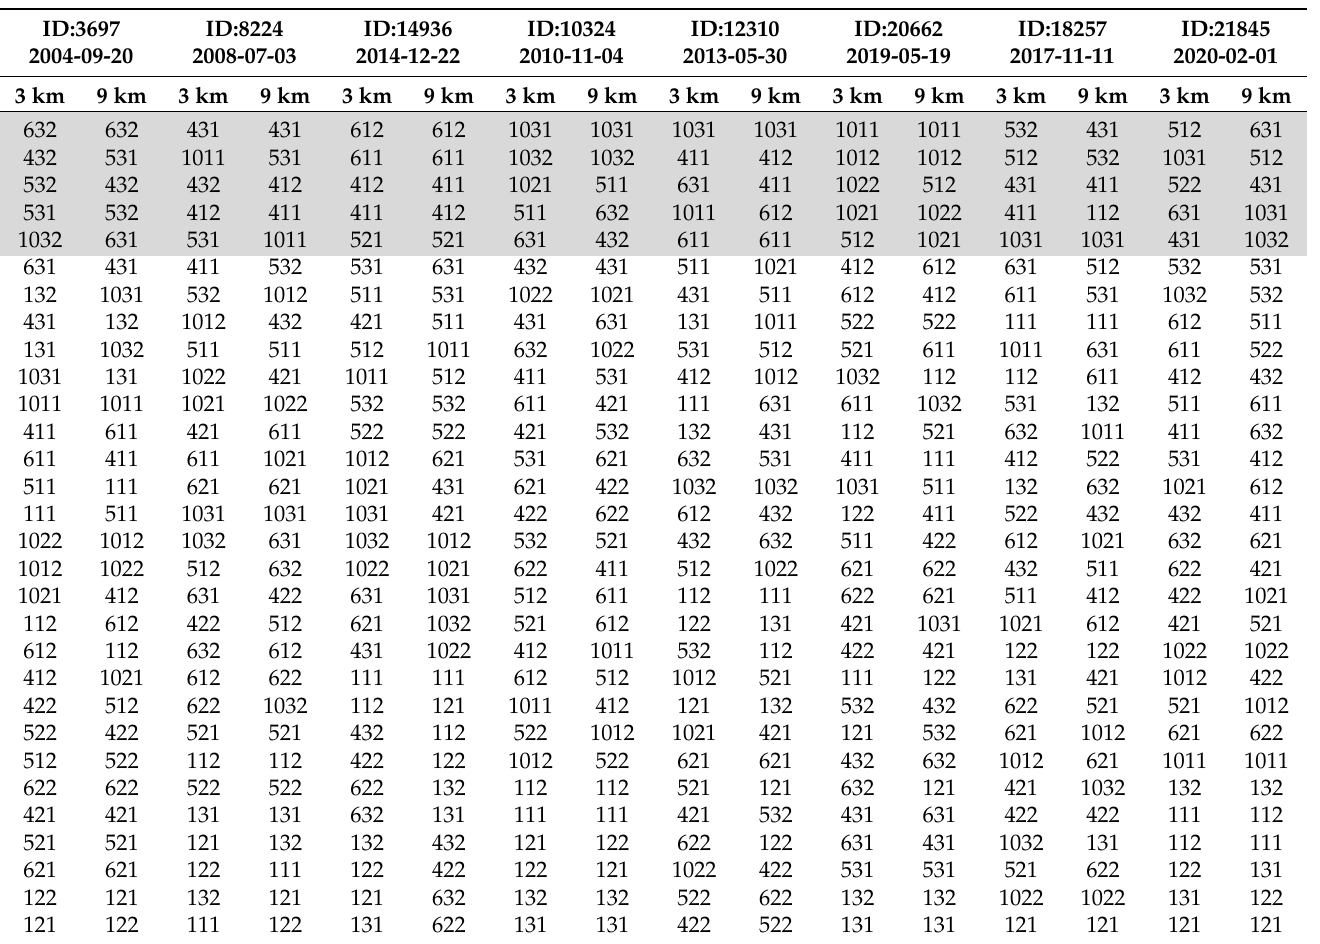
Table 4. TOPSIS scenario ranking for the 3 and 9 km simulations for each event. Top 5 performing scenarios for each episode and grid resolution are highlighted in grey.